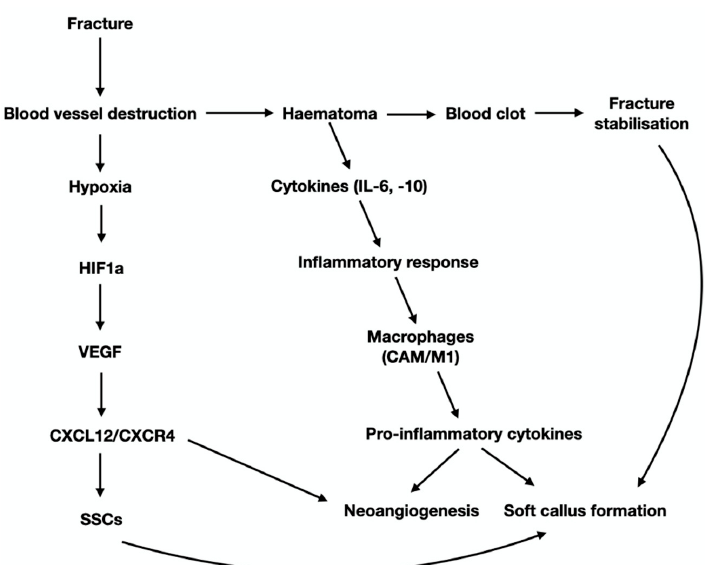
Figure 3. Graphical presentation of the cytokines and molecular signals that participate in the early steps of the anabolic phase of fracture hearing (see text for details).